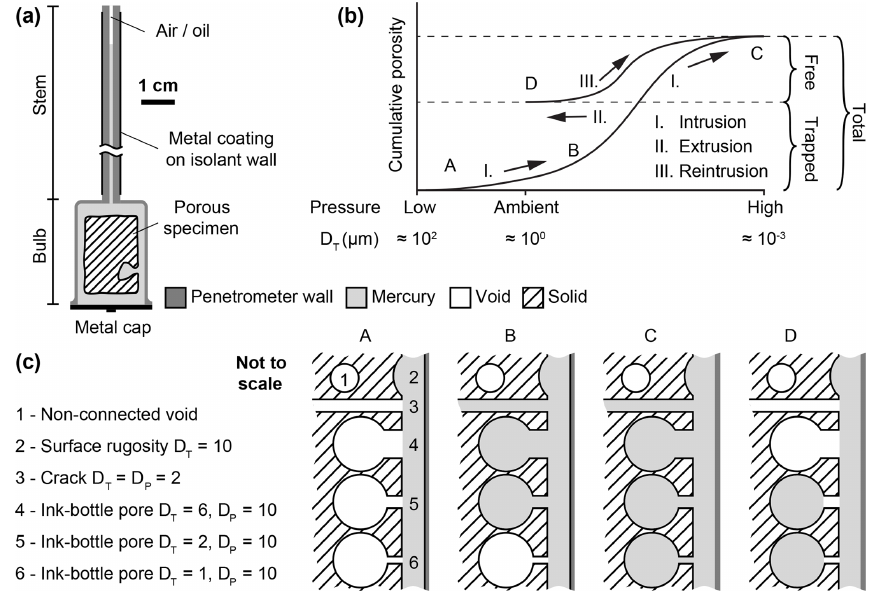
Figure 4. Mercury porosimetry; (a) schematic drawing of a penetrometer (specimen holder); (b) plot of an idealized cumulative porosimetric curve to explain the measurement of connected total, trapped and free porosity by mercury reintrusion, A–D relate to (c) ; (c) schematic drawings of void spaces in a rock specimen to explain the phenomenon of mercury entrapment with respect to different arrangements of throats in relation to pores. D T : throat diameter, D P : pore